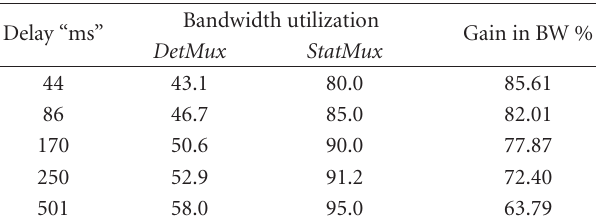
Table 3: Gain of StatMux in di ff erent bu ff ering delays when the bit streams are constrained to a bu ff ering delay of 7 Seconds.